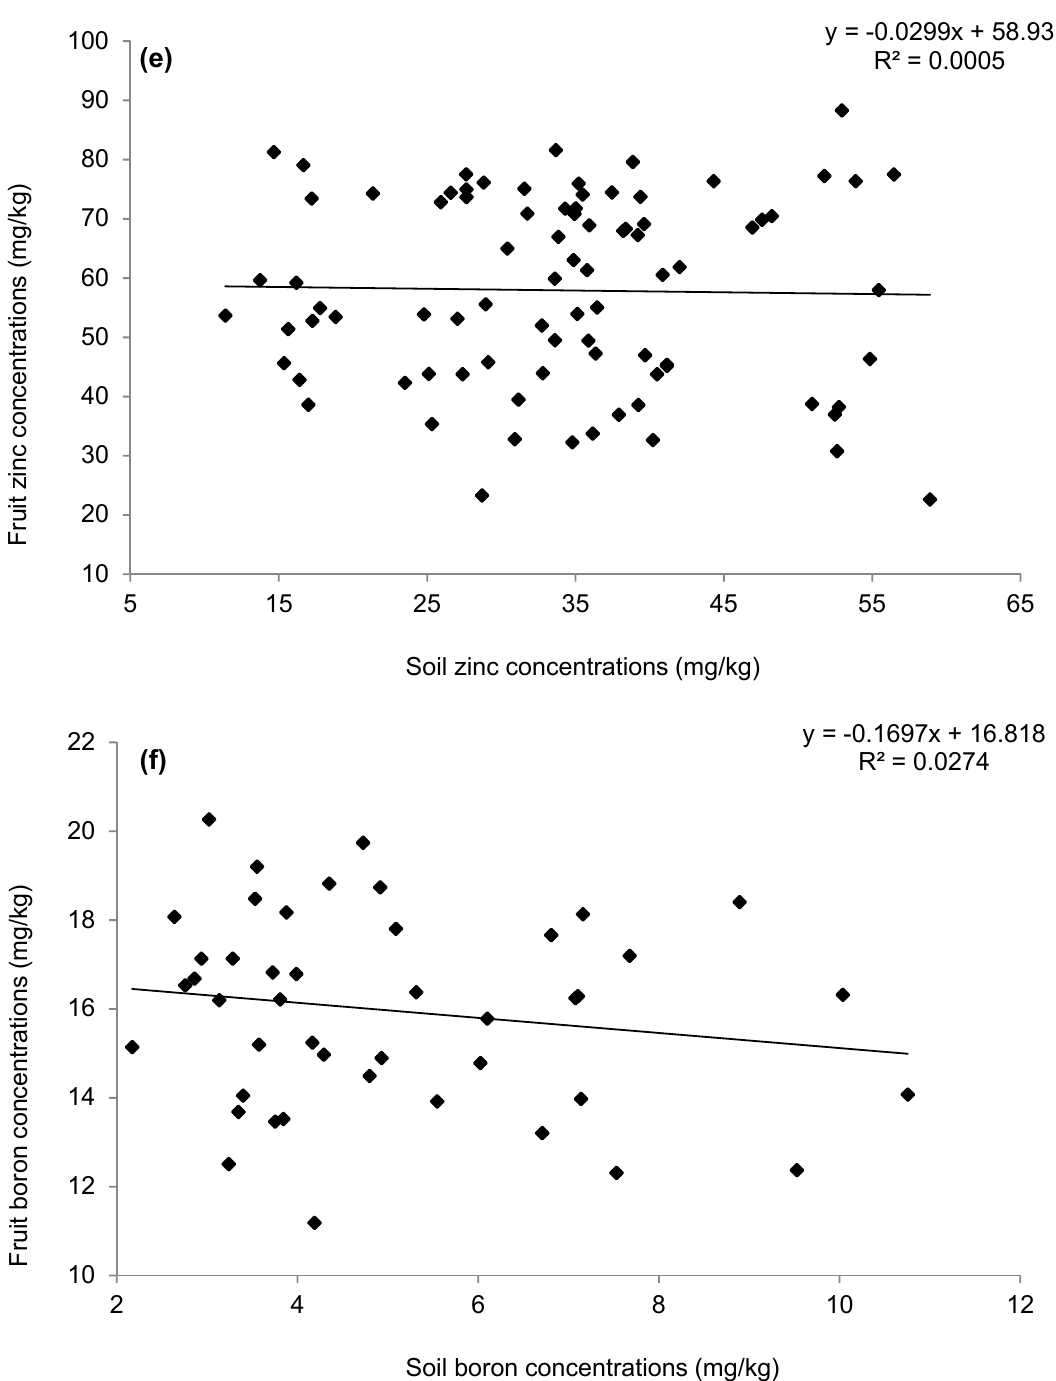
Figure 6. Influence of soil on fruits concerning the elements ( a ) calcium; ( b ) iron, ( c ) magnesium, ( d ) manganese, ( e ) zinc, and ( f ) boron.